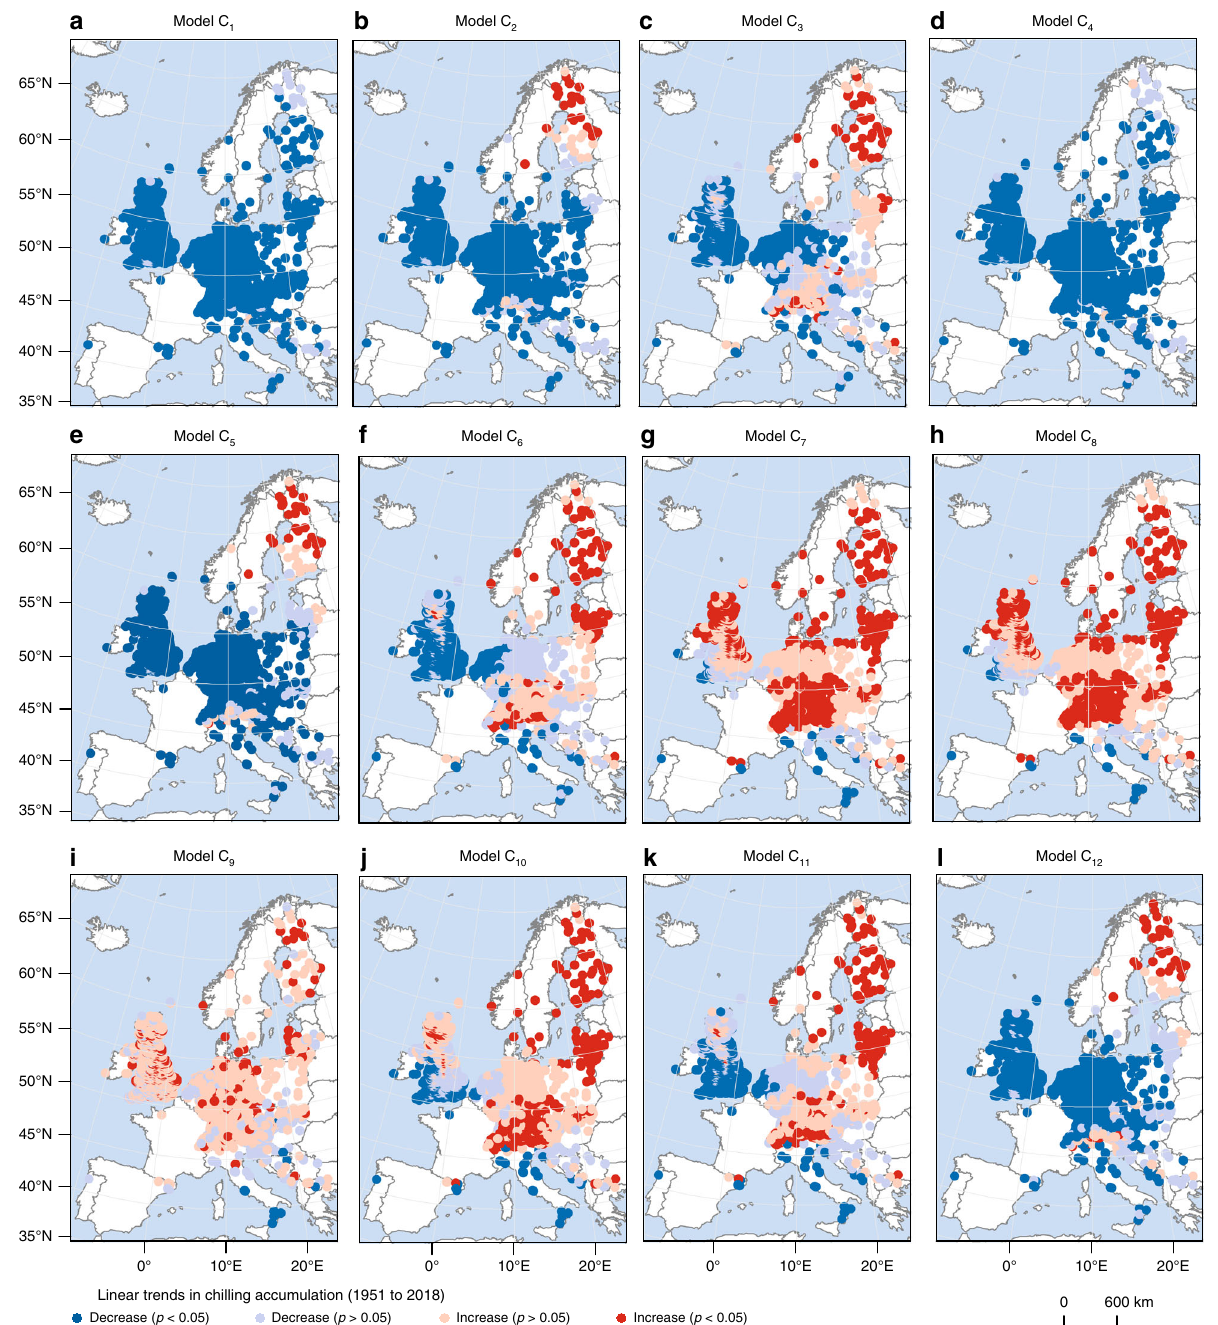
Fig. 2 Spatial patterns of the linear trends in chilling accumulation based on 12 chilling models. The chilling accumulation from 1 November to 30 April was calculated using the 12 chilling models. a – l Models C 1 – C 12 . Dark blue circles, signi fi cant and negative slopes (two-sided F -test, p < 0.01, n = 68 years). Light blue circles, insigni fi cant and negative slopes (two-sided F -test, p > 0.05, n = 68 years). Dark red circles, signi fi cant and positive slopes (two-sided F - test, p < 0.05, n = 68 years). Light red circles, insigni fi cant and positive slopes (two-sided F -test, p > 0.05, n = 68